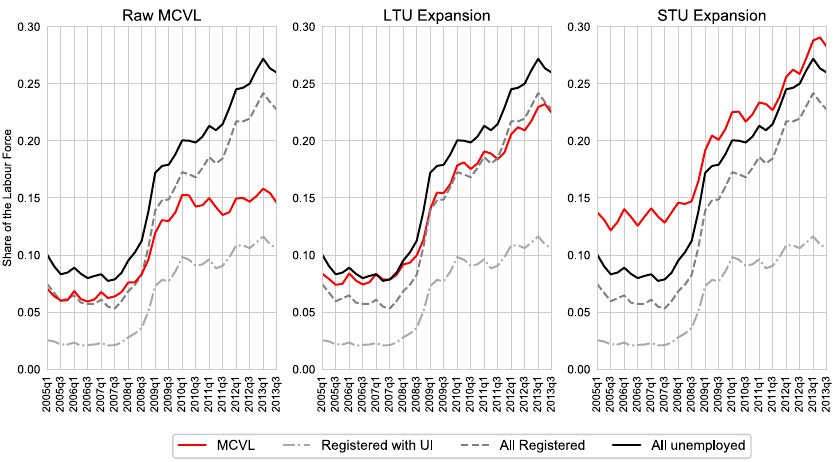
Fig. 17 Alternative unemployment rate series—registered unemployed. Source : MCVL and the